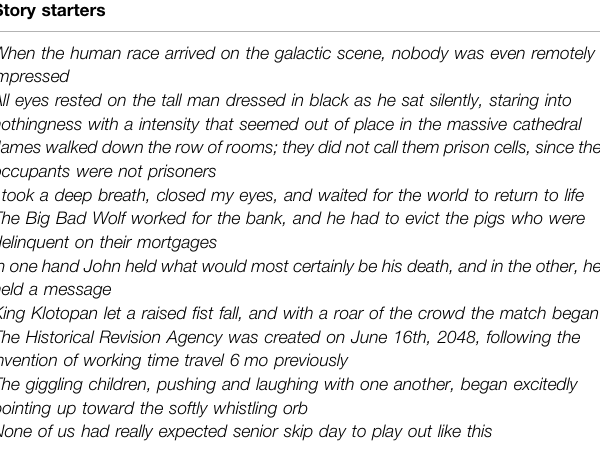
TABLE 1 | Example story starters from r/WritingPrompts . Story